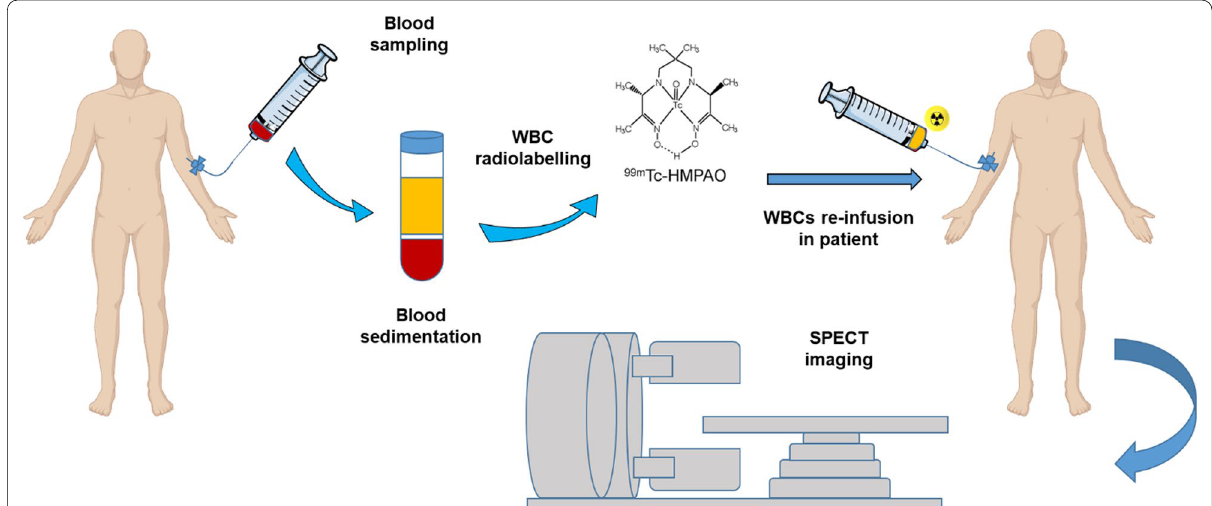
Fig. 4 Schematic representation of direct T-cell labelling imaging approach. After blood sampling, white blood cells (WBCs) are isolated from peripheral blood mononuclear cells (PBMCs) via density-gradient centrifugation, and incubated with [ 99m Tc]Tc-HMPAO (shown in the panel) or alternatively with [ 111 In]In-oxine. The radiolabelled WBCs are then re-infused in patients and their homing in inflamed organs visualized via single photon emission tomography (SPECT)